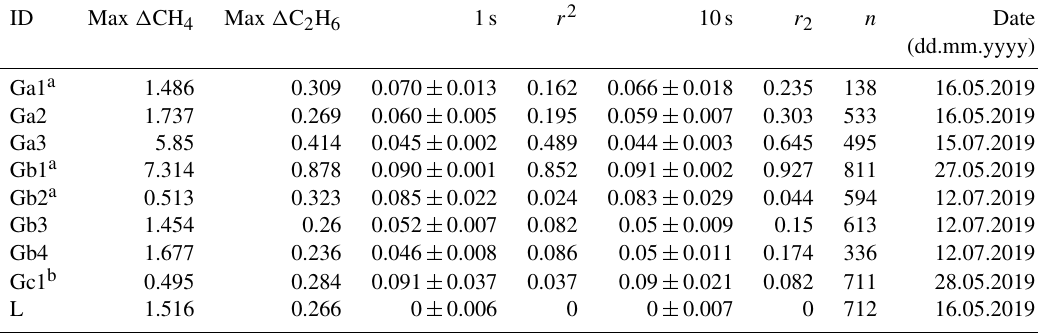
Table D1. Fieldwork analysis. Ga, Gb and Gc: gas compressor; L: